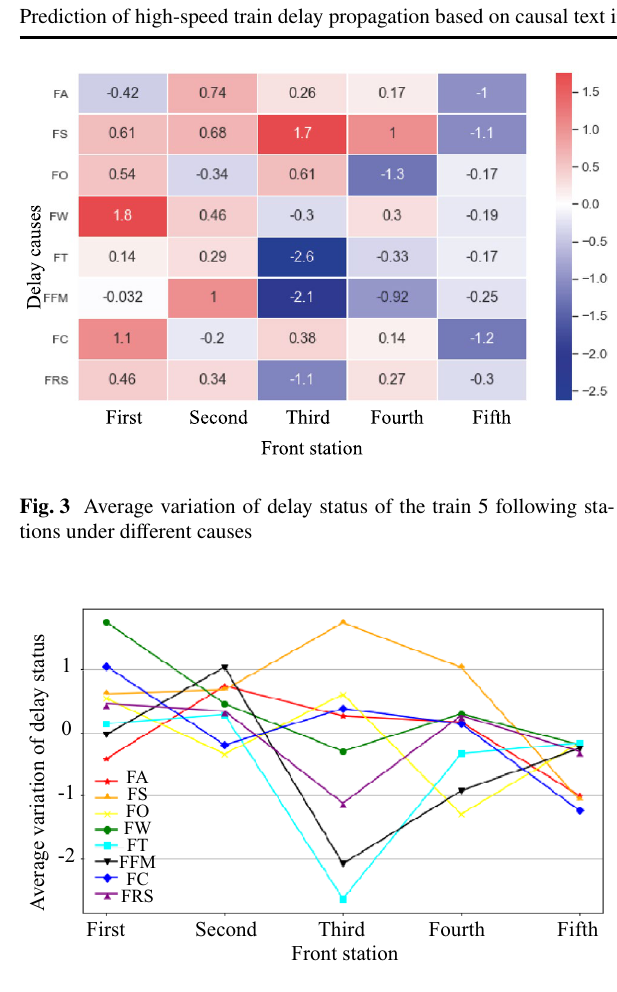
Fig. 4 Average variation of train delay status of the 5 following sta- tions under different